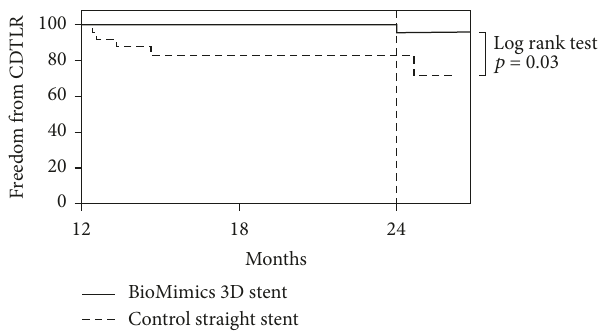
Figure 5: Kaplan-Meier curves of freedom from clinically driven target lesion revascularization (CDTLR) after independent event adjudication for the helical centerline stent versus the control straight stent for the landmark period between 12 and 24 months in the MIMICS clinical